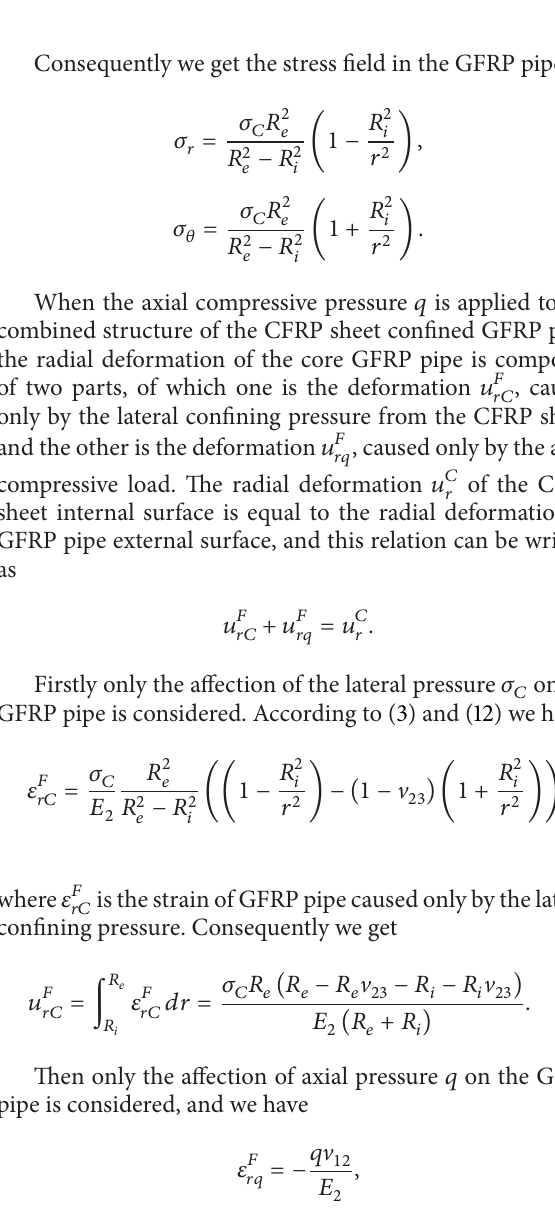
Figure 3: Mechanical model of the CFRP sheet confined GFRP short pipe: (a) combined structure; (b) forces equilibrium condition of the CFRP sheet; (c) forces equilibrium condition of the GFRP short